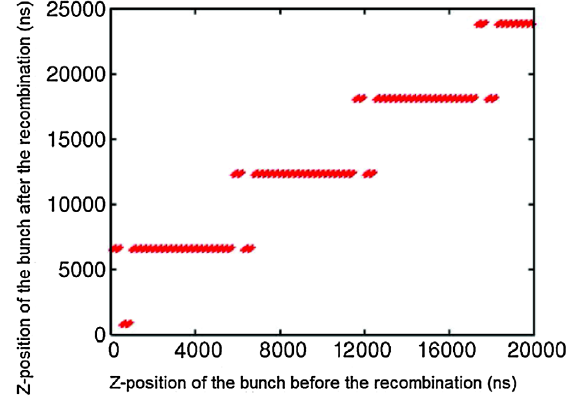
FIG. 9. Bunch z -position after passing the drive beam recom- bination scheme vs bunch z -position before.